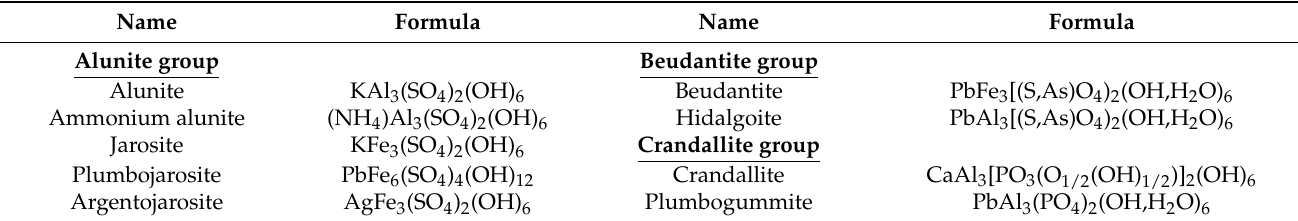
Table 1. Examples of compounds of the alunite supergroup.